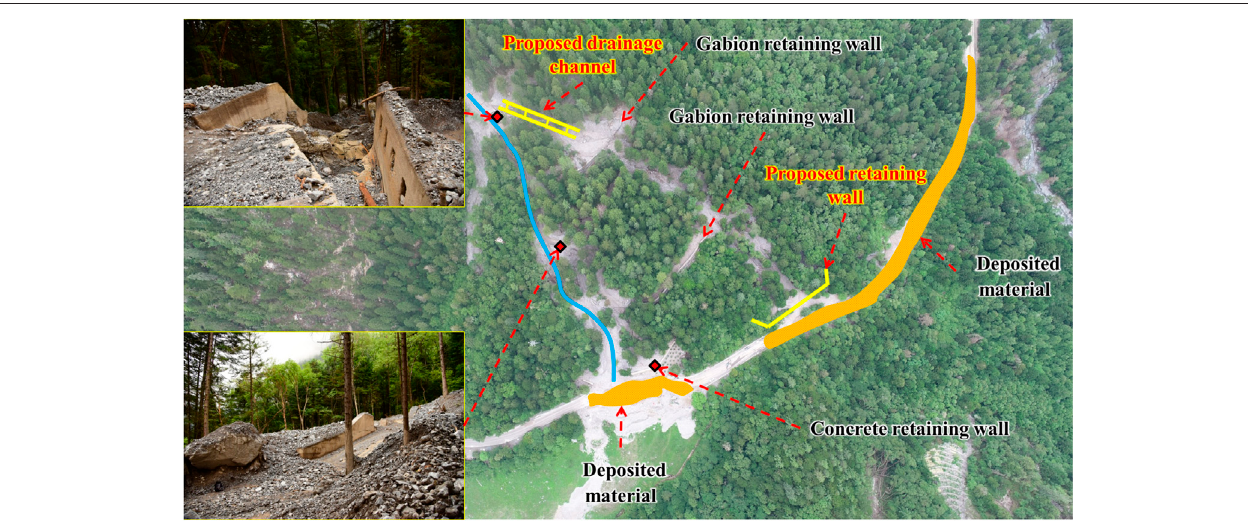
FIGURE4| ControlengineeringlayoutofXiajijieLakeGully(afterthedebris fl oweventonJune21,2019).Thebluelineinthe fi gurerepresentsthemainchannel.The proposed drainage channel and retaining wall in the fi gure are the proposed engineering projects described in Application of the Planning Method for the Xiajijie Lake, Zhuozhui, Pingshitou, Xuan, and West-Zhuozhui Debris Flow Gullies section.